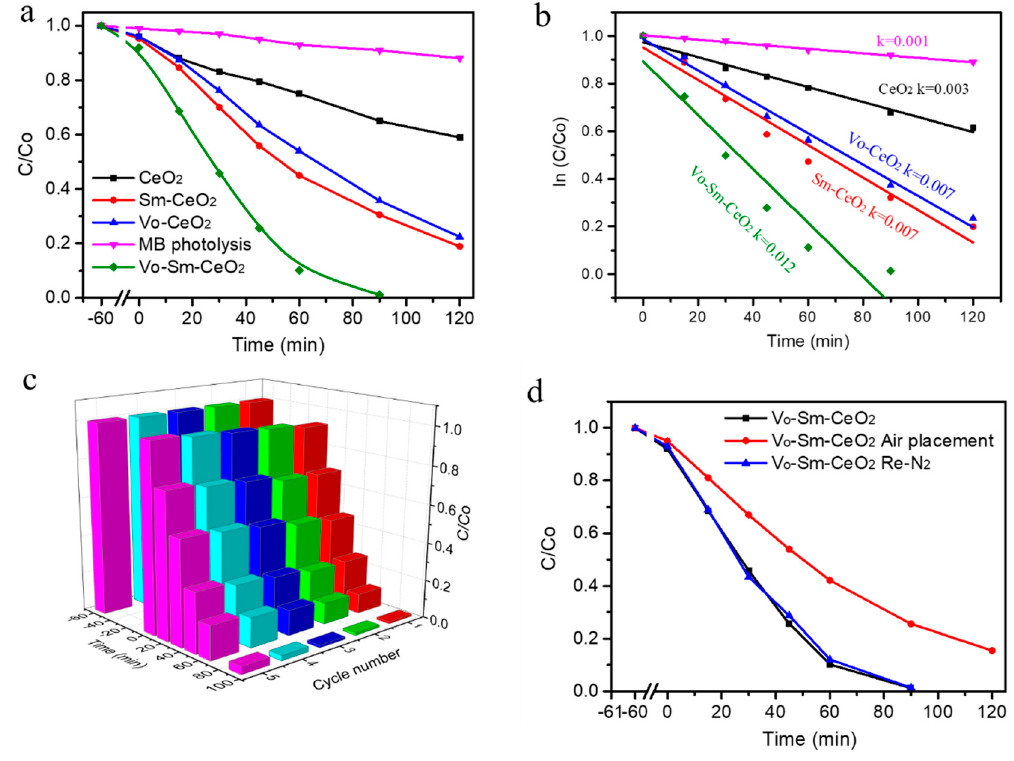
Figure 4. ( a ) Photocatalytic performance of the degradation of MB, ( b ) reaction kinetic, ( c )